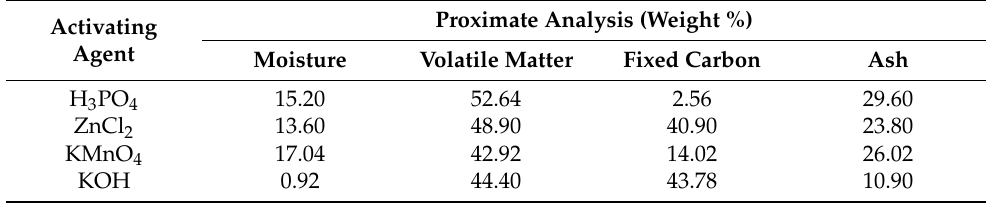
Figure 4. ( a ) Thermogravimetric and ( b ) thermogravimetric derivative curves for activated carbons from sago waste prepared using various chemical activating agents. Table 3. Proximate analyses of activated carbons from sago waste prepared using various chemical activating agents.